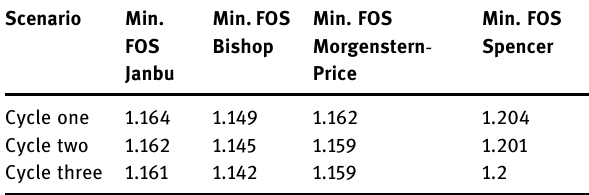
Table 4: Value of minimum FOS for many scenarios Scenario